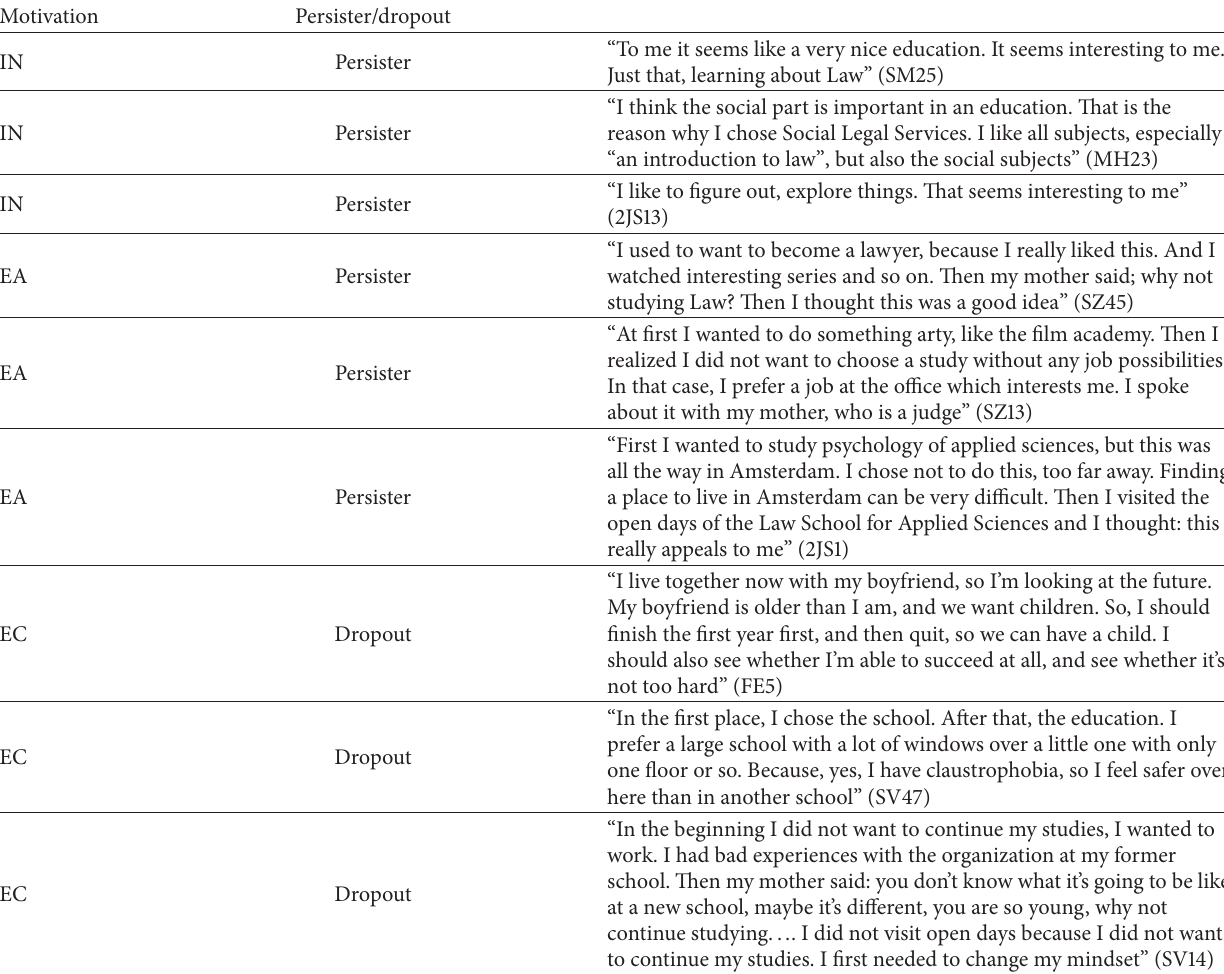
Table 6: Examples of quotes representative for different forms of motivation.